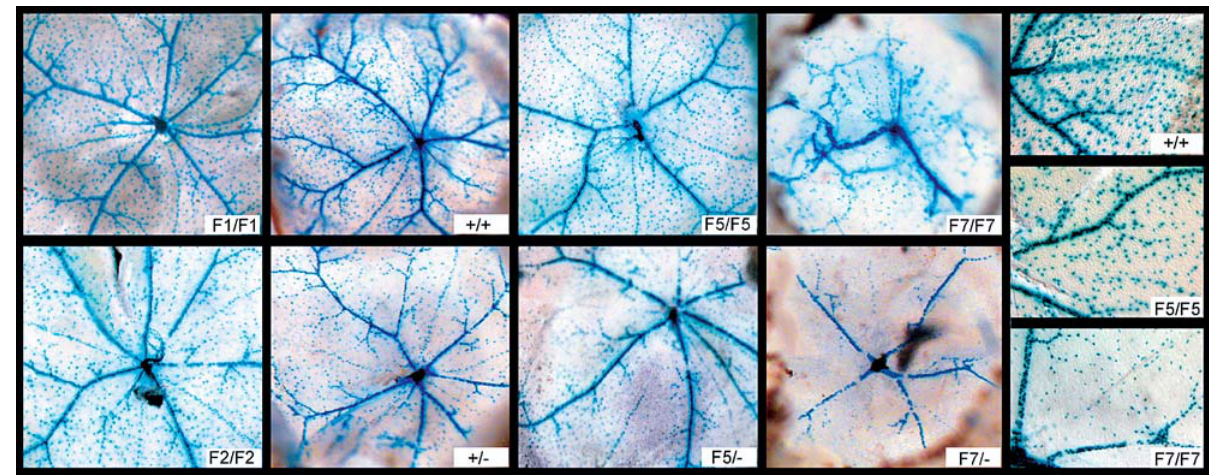
Figure 8. V/P Populations in P28 Retinas Whole-mount retinal preparations from wild-type and mutant eyes. Pigmented epithelium was removed for visualization of b -galactosidase. Note F7/F7 and F7/ (cid:1) had extensive thickening of the retinal layers that resulted in a contraction of the entire retina and apparent reduction in size. The far right panel shows a close-up of the artery and vein of three homozygous eyes. DOI: